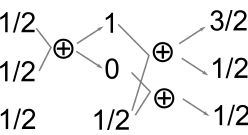
Figure 7. Procedure for adding up the angular momenta for the A 3 spin